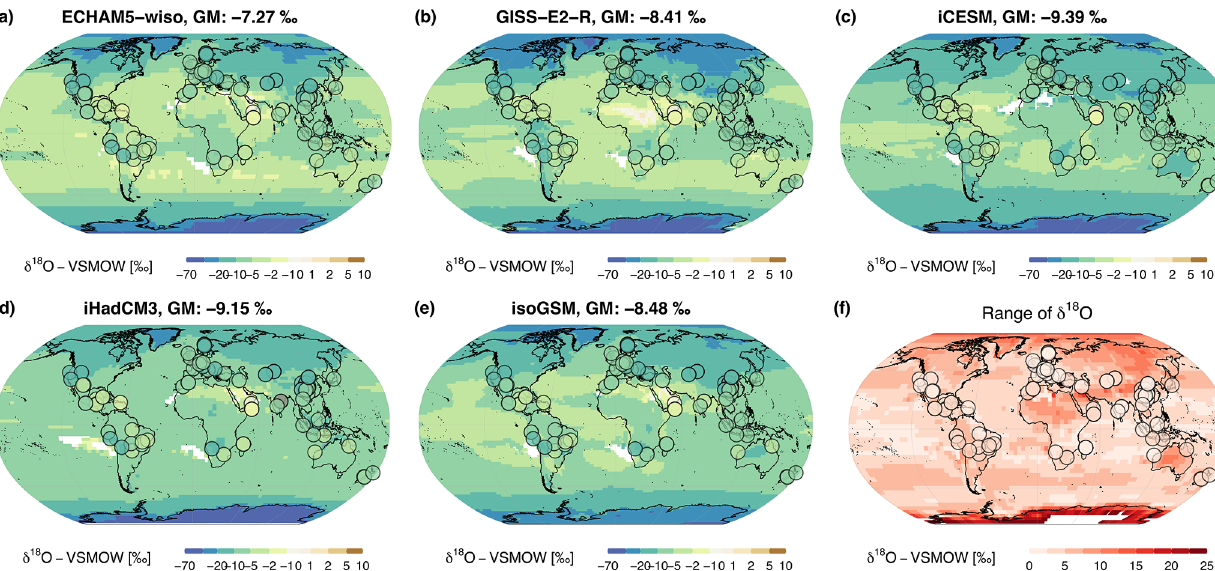
Figure 3. Simulated δ 18 O iw climatology (a–e) of the respective simulation: (a) ECHAM5-wiso, (b) GISS-E2-R, (c) iCESM, (d) iHadCM3, and (e) isoGSM in the background. The time-averaged mean δ 18 O dweq values using the respective simulated temperatures are depicted as circles. Global means (GM) of δ 18 O iw are given in the title of each subplot. (f) The range of δ 18 O iw between all simulations for each grid box, as well as the range for the difference between simulation and record. Light colors indicate large agreement between the simulations, while darker colors mark areas where the models differ strongly and the spread between the δ 18 O iw is larger. Antarctic δ 18 O iw ranges are up to 40‰, highlighting the different model performance in this region (white area in f